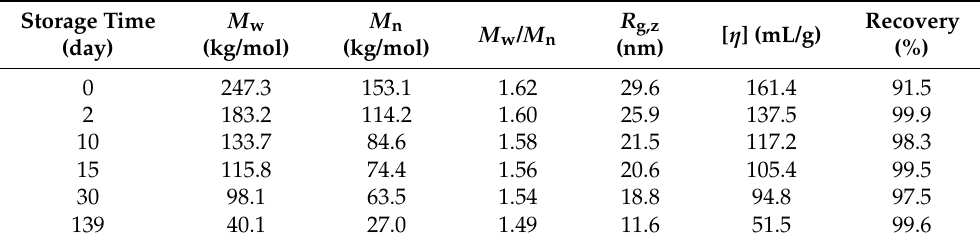
Table 5. Molecular parameters of (6FDA-DMB) PAA in a concentrated solution stored at 25 ◦ C for different times, measured by